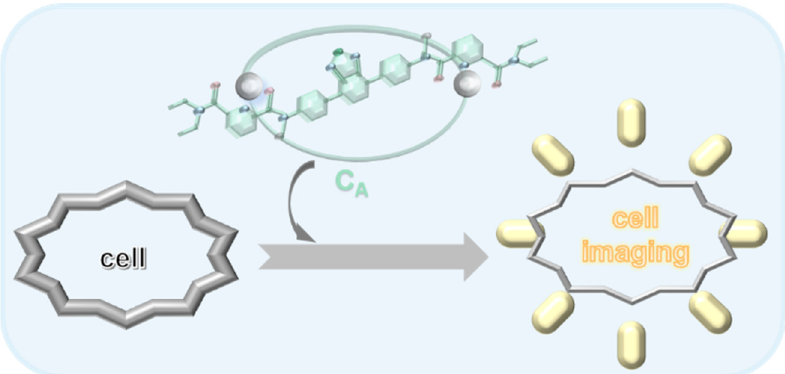
Figure 1 . The preparation and characterization of C A. Figure 1. The preparation and characterization of C